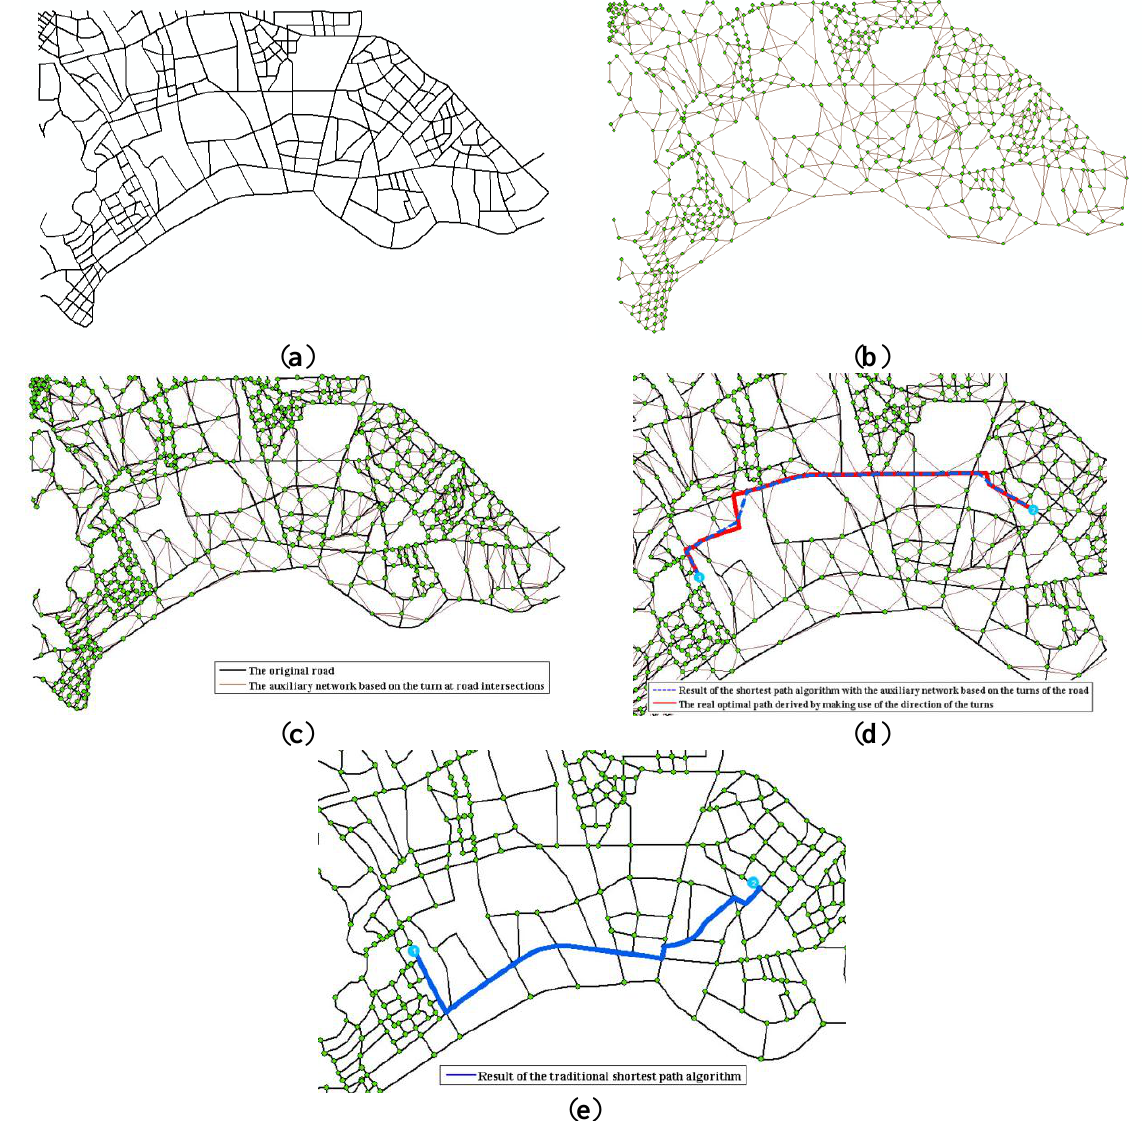
Figure 8. Comparison of the results of the traditional algorithm and the one based on the weighted model of corners: ( a ) road map of a city in Qingdao; ( b ) network based on the weight values of the corners at road intersections; ( c ) superimposed renderings; ( d ) result of the shortest path analysis with the weighted model of corners; and ( e ) result of the existing traditional